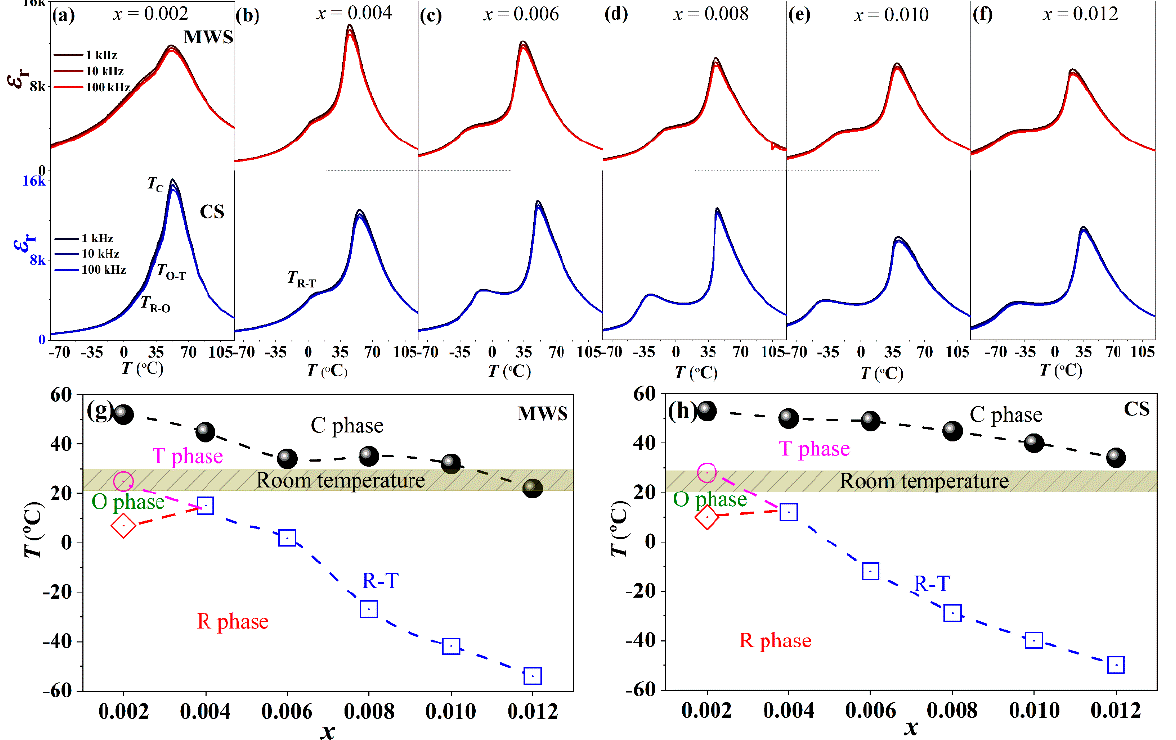
Figure 2. ( a – f ) ε r- T curves from − 80 °C to 120 °C of BTS-BCT- x BF ceramics sintered with MWS and CS. ( g , h ) Phase diagrams of BTS-BCT- x BF ceramics sintered with MWS and CS, respectively.